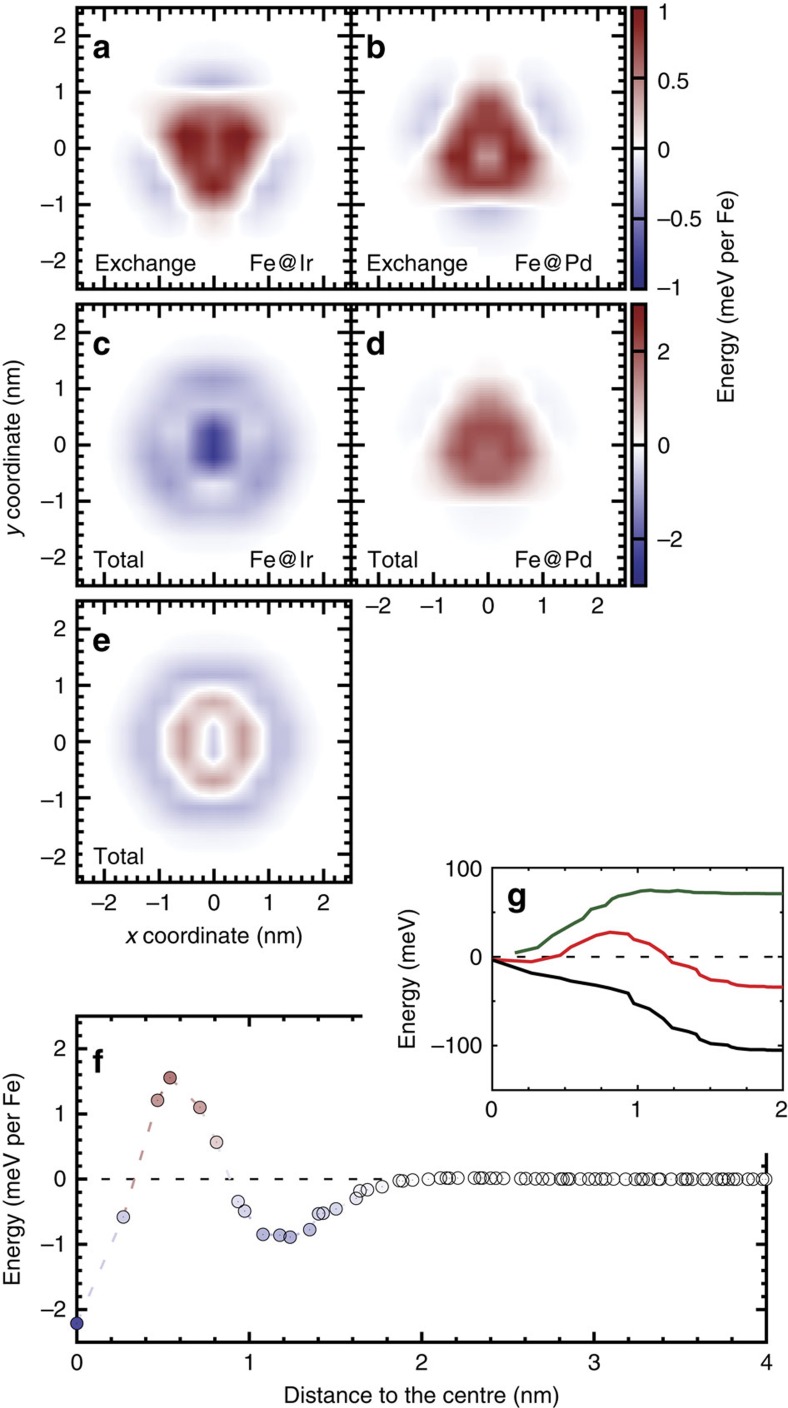
Site-resolved energy contributions for a skyrmion in the multilayer Rh/Pd/2Fe/2Ir.The isolated skyrmion has been obtained at a magnetic field of B=3.5 T (cf. skyrmion profile in Fig. 3). (a,b) The exchange energy in the Fe layer at the Ir interface (Fe@Ir) and at the Pd interface (Fe@Pd), respectively. (c,d) The total energy (exchange, DMI, Zeeman and anisotropy) for the two Fe layers and (e) for the complete Fe bilayer. The colour scale bar of the energy is given to the right of the panels, indicating stabilizing (E<0) and destabilizing (E>0) contributions. For (e), the scale bar is the same as for c,d. (f) Total energy per Fe atom averaged over the δth neighbour shell for e. The inset (g) shows the total energy summed over the shells from the skyrmion centre up to the radius r of the Fe bilayer (red), Fe@Pd (green) and Fe@Ir (black).